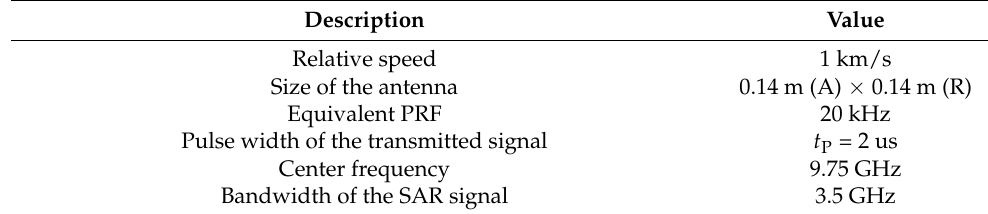
Table 2. Simulated parameters of the proposed non-uniform hybrid sampling